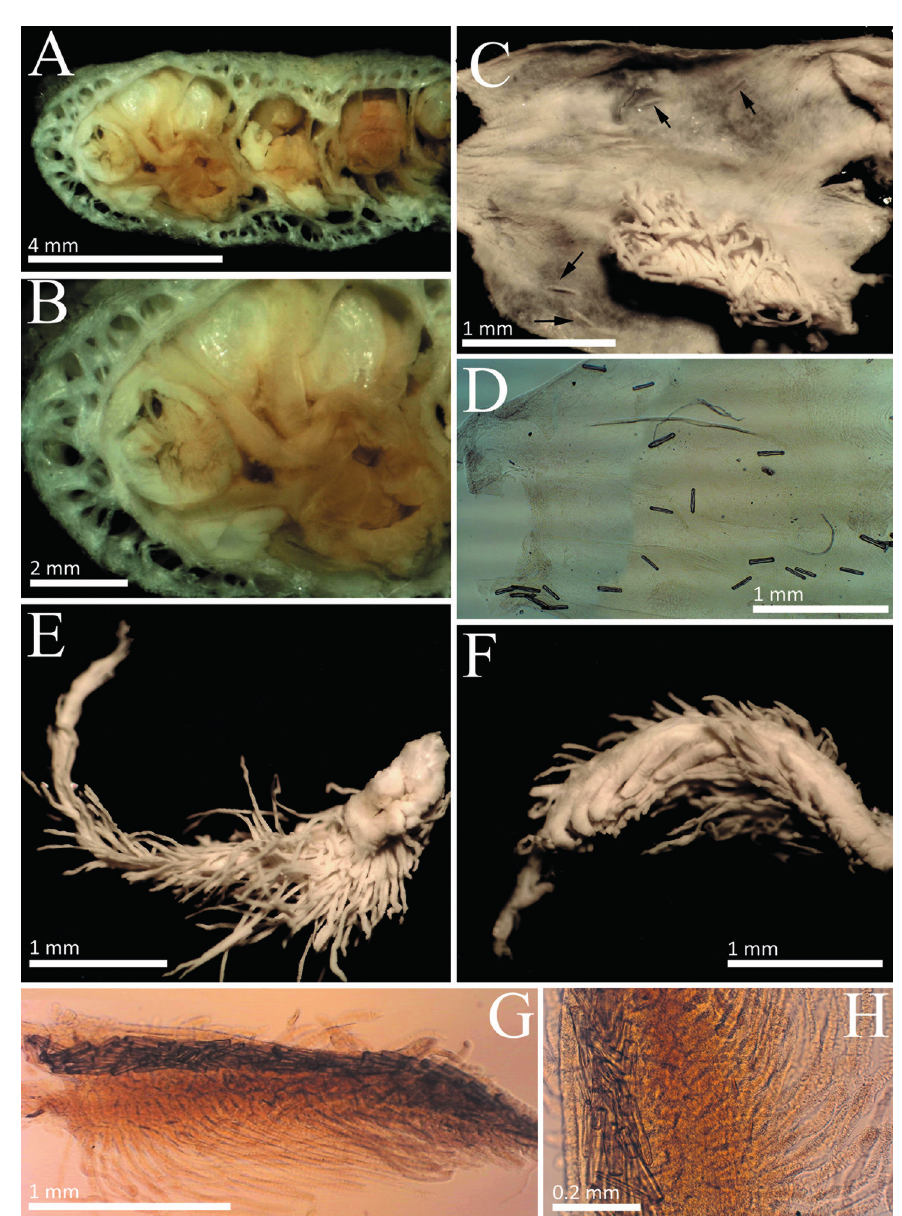
Fig. 8. Gyrophyllum hirondellei Studer, 1891, BECA (OPEN-660). A . Transversal section of a polyp leaf, showing its trabecular walls, and the thin barriers between consecutive gastrovascular cavities that are disposed in a line. B . Detail from A (the gastrovascular cavity on the left), showing also pharynx, mesenteria, sclerites of the tentacular axis (visible due to the transparency of oral disc), and (sectioned) one of the oral ‘pouches’ into which each tentacle is partially retracted. C . Internal view of the autozooids body wall into which the tentacular crown retracts (this becomes the outer body wall when the autozooid is extended). Note on the bottom right one of the tentacles and several sclerites (arrowed) in the thin body wall of the autozooid. D . Autozooid body wall treated with clove oil to clear tissue with scattered sclerites now easily observed in situ. E . Single tentacle in oral view (after critical point treatment) showing the numerous filiform structures. F . Single tentacle in lateral view (after critical point treatment) showing a series of normal pinnulae, part of the aboral side of tentacle and filiform structures. G . Single tentacle treated with clove oil to observe the presence and disposition of sclerites along the tentacular axis. H . Detail from G, also showing filiform